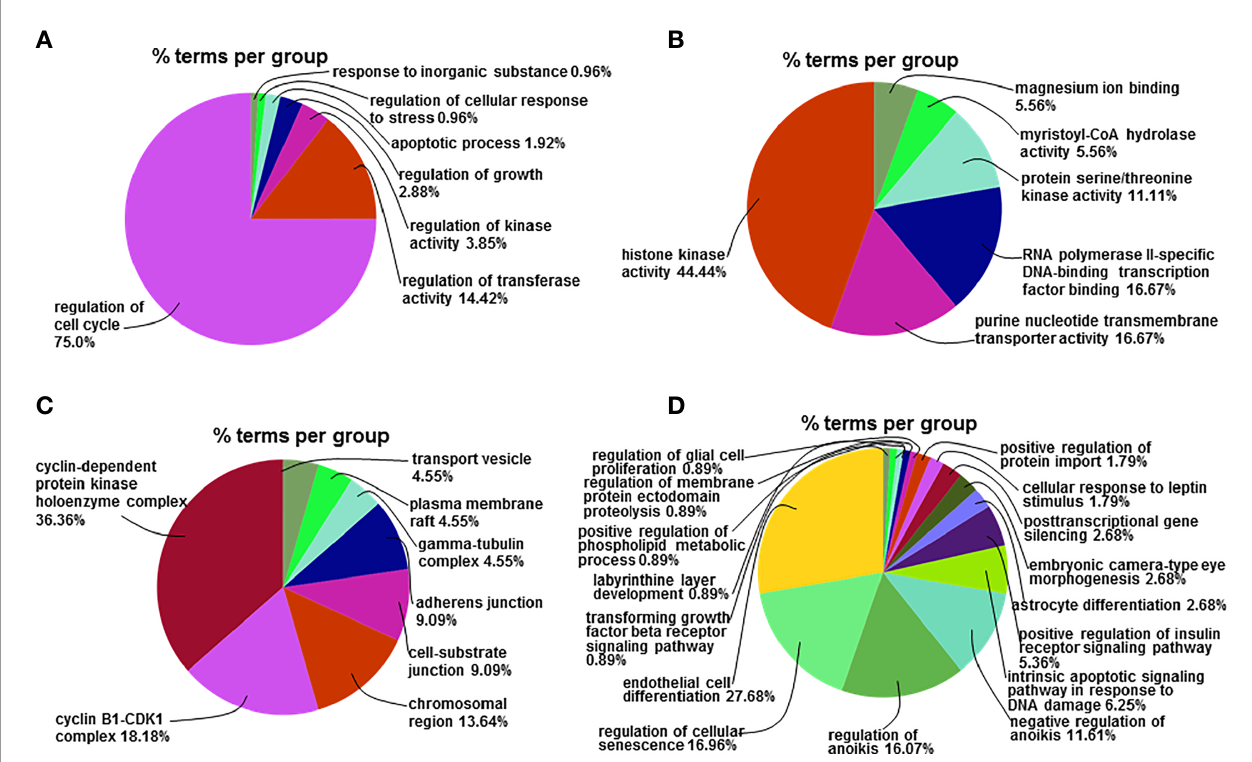
FIGURE 6 | Go functional analysis of the differentially expressed miRNA-related target genes. (A) The percentage of the up-regulated mRNAs-related GO-BP terms enriched in the corresponding group in total up-regulated mRNAs-related GO-BP terms. (B) The percentage of the up-regulated mRNAs-related GO-MF terms enriched in the corresponding group in total up-regulated mRNAs-related GO-MF terms. (C) The percentage of the up-regulated mRNAs-related GO-CC terms enriched in the corresponding group in total up-regulated mRNAs-related GO-CC terms. (D) The percentage of the down-regulated mRNAs-related GO-BP terms enriched in the corresponding group in total down-regulated mRNAs-related GO-BP